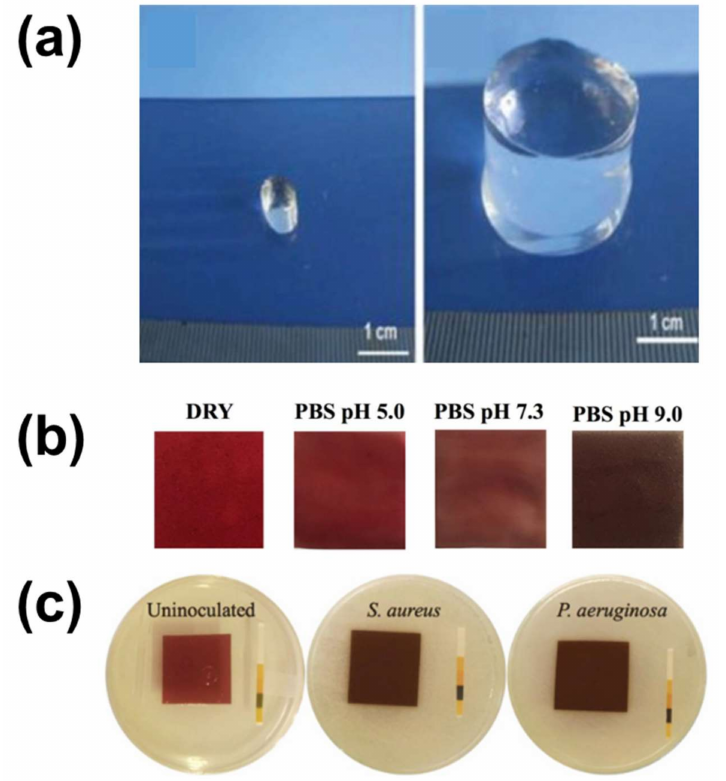
Figure 7. ( a ) The swelling of a nanocomposite hydrogel that is able to maintain its structural integrity [207]. Adapted under terms of the CC-BY license. Color changes of carrageenan/gum- based hydrogel containing cranberry extract ( b ) upon immersion into buffer solution of different pH, relevant to skin wound pH values; ( c ) upon exposure to bacteria. ( b , c ) Adapted with permission from Ref.